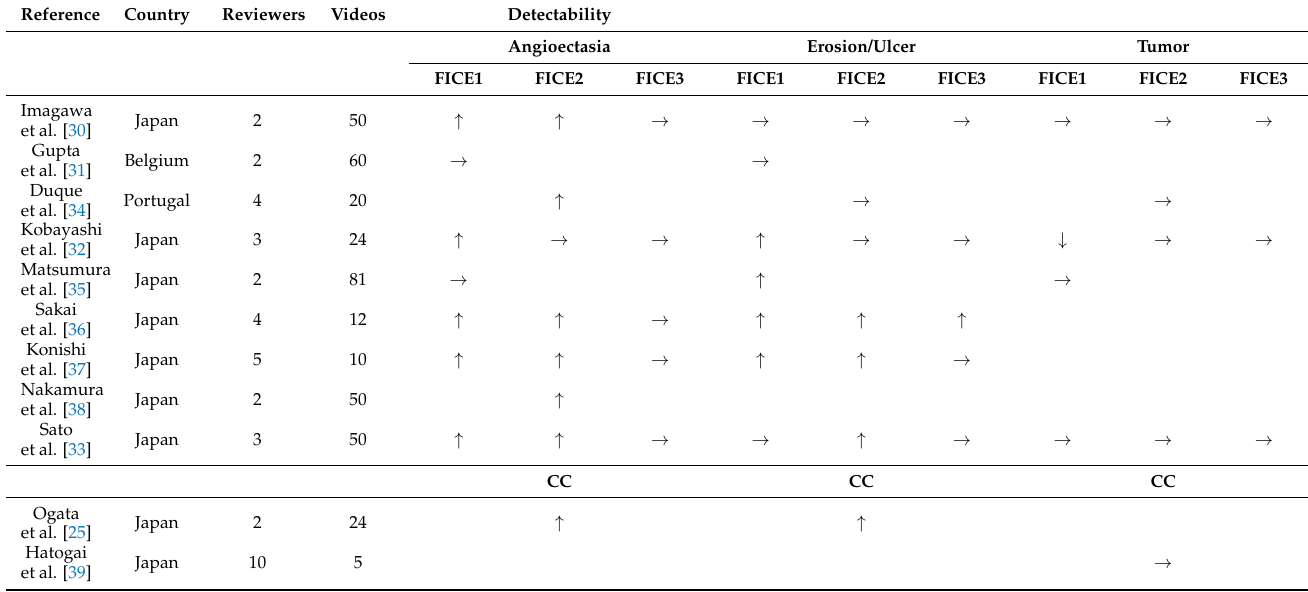
Table 1. Clinical studies involving image-enhanced capsule endoscopy for the detectability of small intestinal lesions. Reference